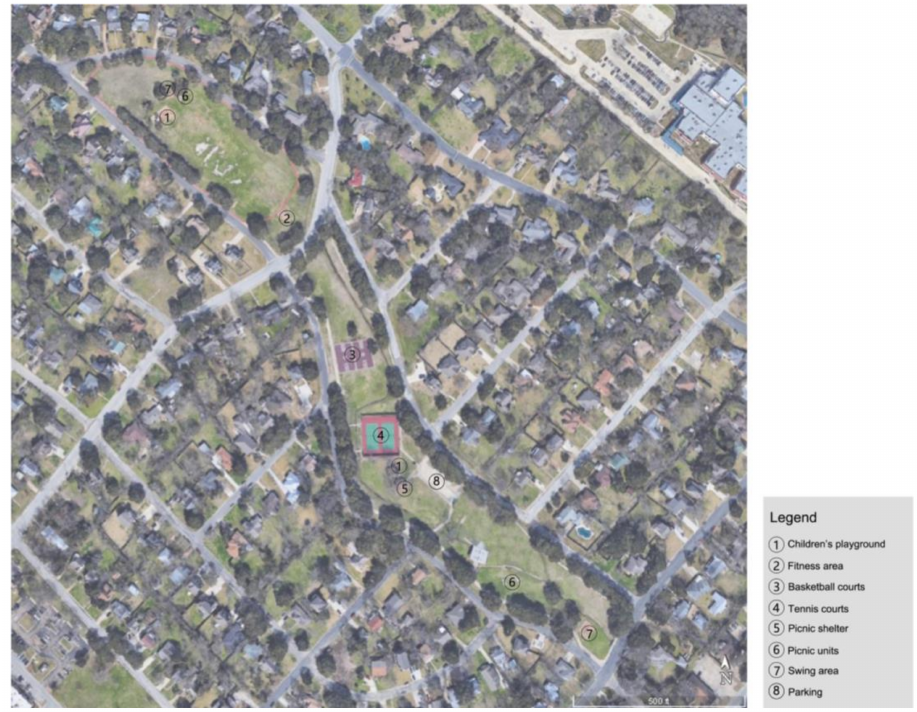
Figure 1. Thomas Park’s existing master